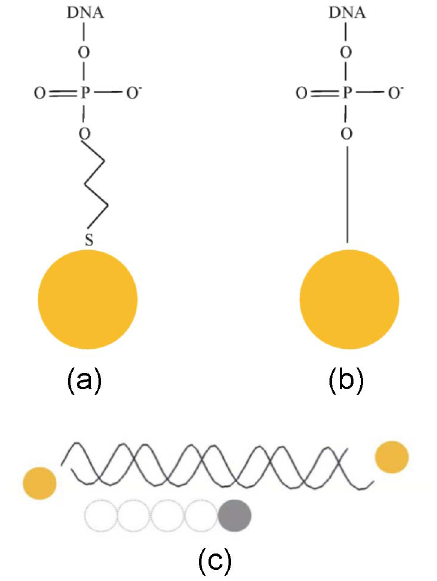
Figure 1. Diagram of nanocrystal attachment to DNA molecule (a) the thiol linkage to the gold nanocrystal [13] (b) gold nanocrystal position as defined in coordinate file (c) gold and platinum nanocrystals on a 50 base-pair DNA molecule. The dotted circles show the various positions for the platinum nanocrystal.